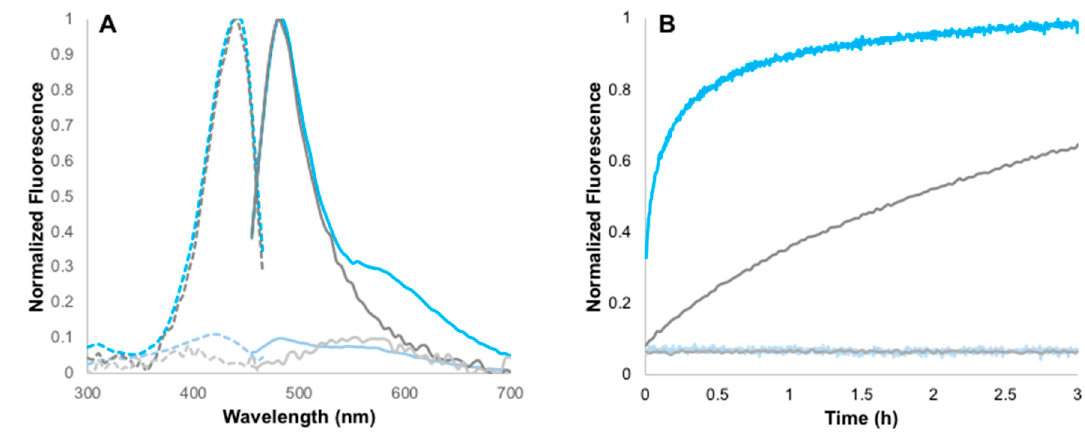
Figure 3. ( A ) Excitation (dotted line) and emission (solid line) spectra of 10 µ M 10 (grey lines) and 15 (blue lines) before (light) and after (dark) reacting with 10 µ M MBP-dC10*. ( B ) Kinetic time course for the fluorogenic reaction between 10 µ M of 10 (grey lines) and 15 (blue lines) with 10 µ M of MBP-dC10* (dark lines) (black), relative to the stability of 10 and 15 in the absence of MBP-dC10* (light lines). Using the same synthetic strategy outlined in Scheme 4, aniline 4 was coupled to 14 through the acyl chloride a ff orded by POCl 3 to obtain 15 in decent yield. Upon reacting with equimolar amounts of MBP-dC10* at 10 µ M, the fluorescence intensity of 15 was found to increase 10-fold. The final MBP-dC10*- 15 adduct displayed a quantum yield of Φ = 0.093, which is 57 times higher